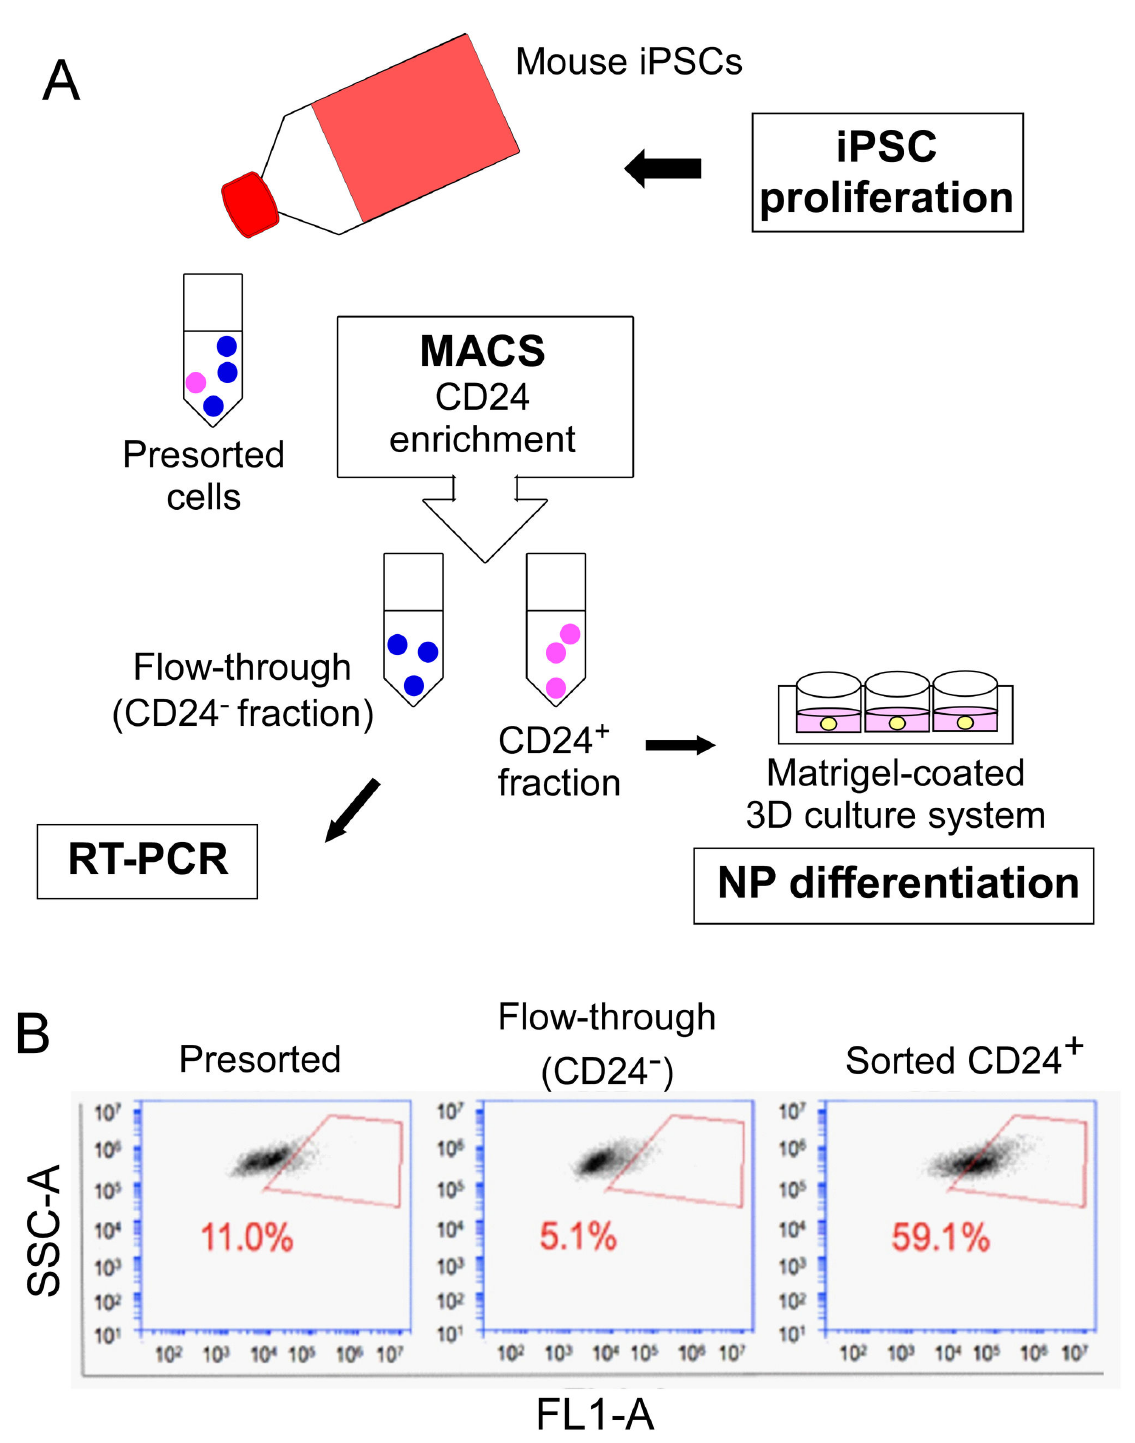
Figure 2. Enrichment of CD24 + cell population from undifferentiated iPSCs via magnetic activated cell sorting (MACS). (A) General experimental overview. (B) Flow cytometry analysis for the expression of CD24 in presorted, “flow-through” and sorted cell fractions. Undifferentiated iPSCs incubated with CD24 antibody and magnetic beads were passed through a MACS column, yielding a CD24 + fraction of cells; in the “flow-through” fraction, ~ 5.1% of total cells on average were found to express CD24, which was less than that in the presorted fraction. The gated readouts represent the percentage of cells expressed CD24 in presorted cells and sorted fractions from one sorting experiment. doi: 10.1371/journal.pone.0075548.g002 PLOS ONE |